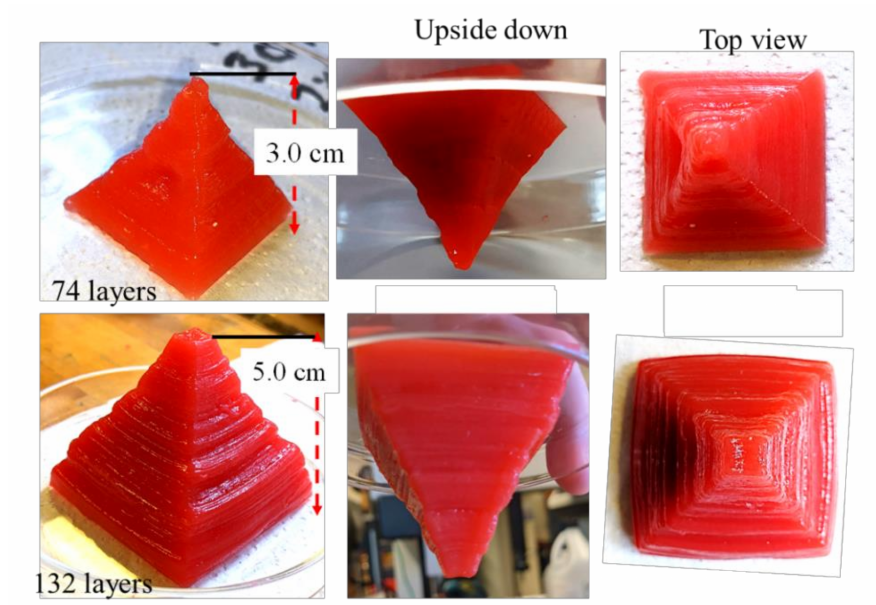
Figure 14. Pyramid structure fabricated using A 3 C 3 CS 1.5 . It preserved the external and internal geometric fidelity and showed minimal discrepancy with respect to the digital model we used for